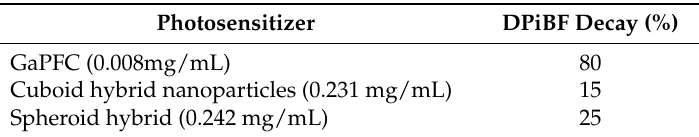
Table 2. Singlet oxygen generation